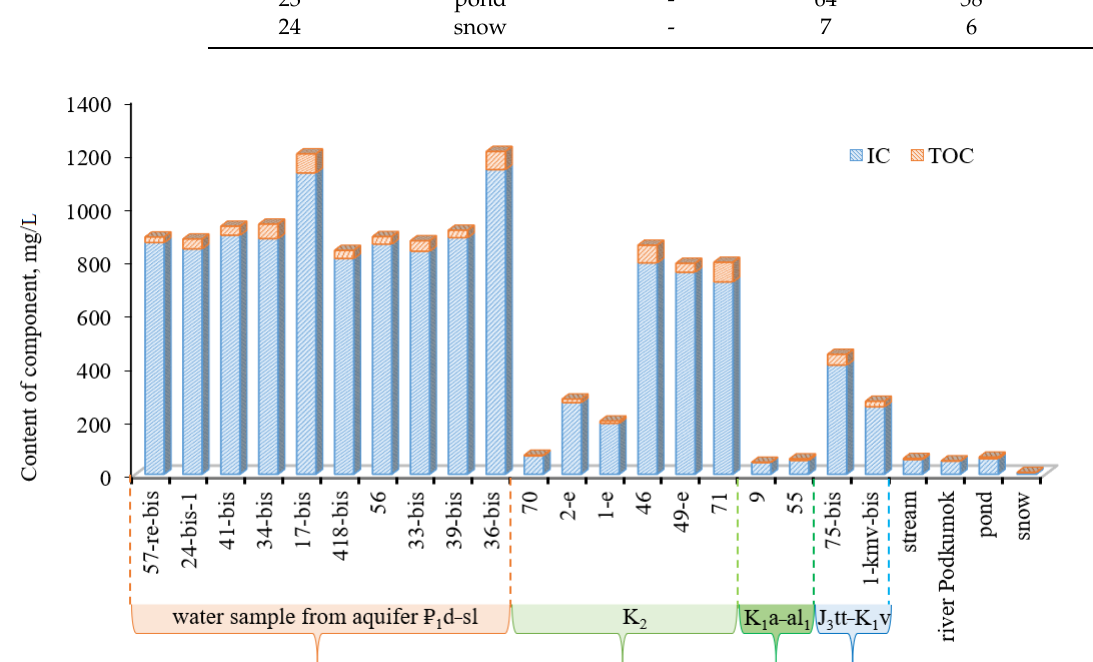
Figure 9. Distribution of various forms of carbon in water samples of the Essentuki field. Table 3. Content of various forms of carbon in water samples of the study area.